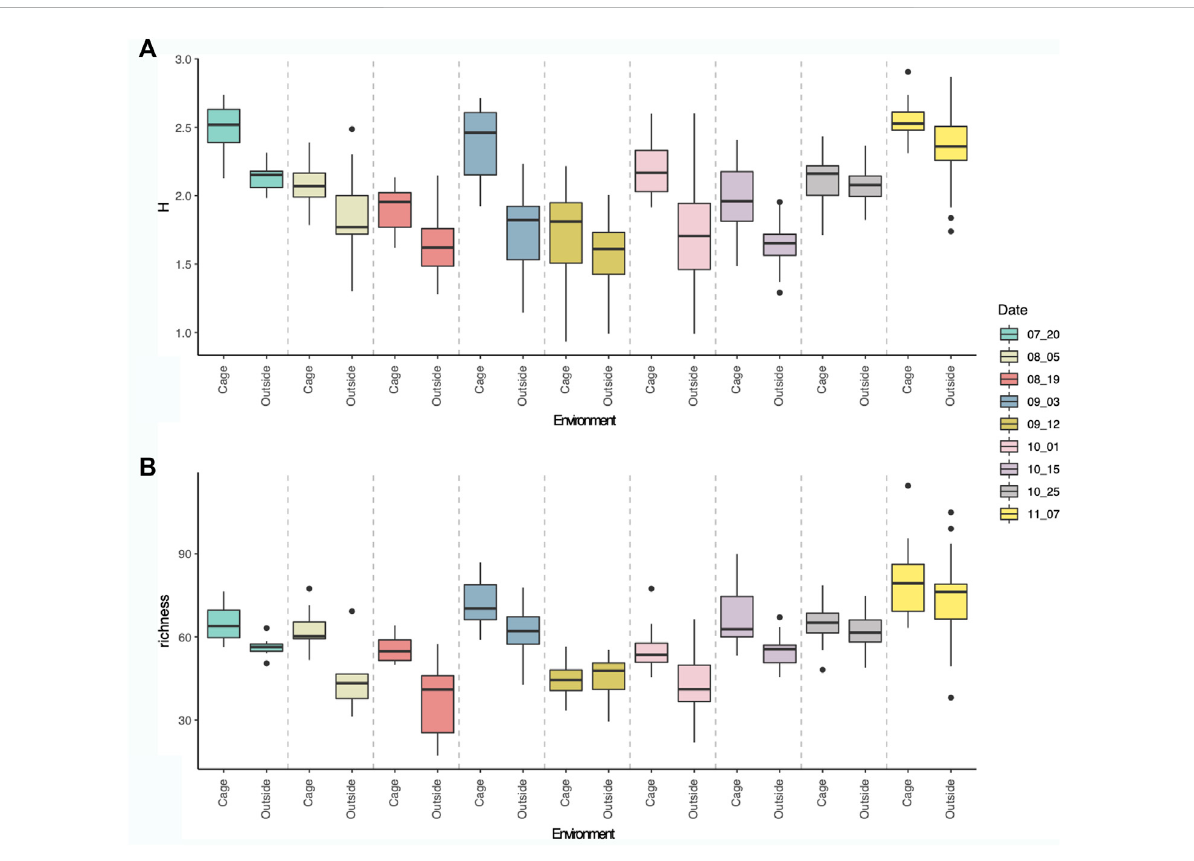
FIGURE 4 Boxplot showing Shannon diversity index (A) and Richness (B) of eukaryotic communities per sampling dates, inside ( fi rst) and outside (second) the